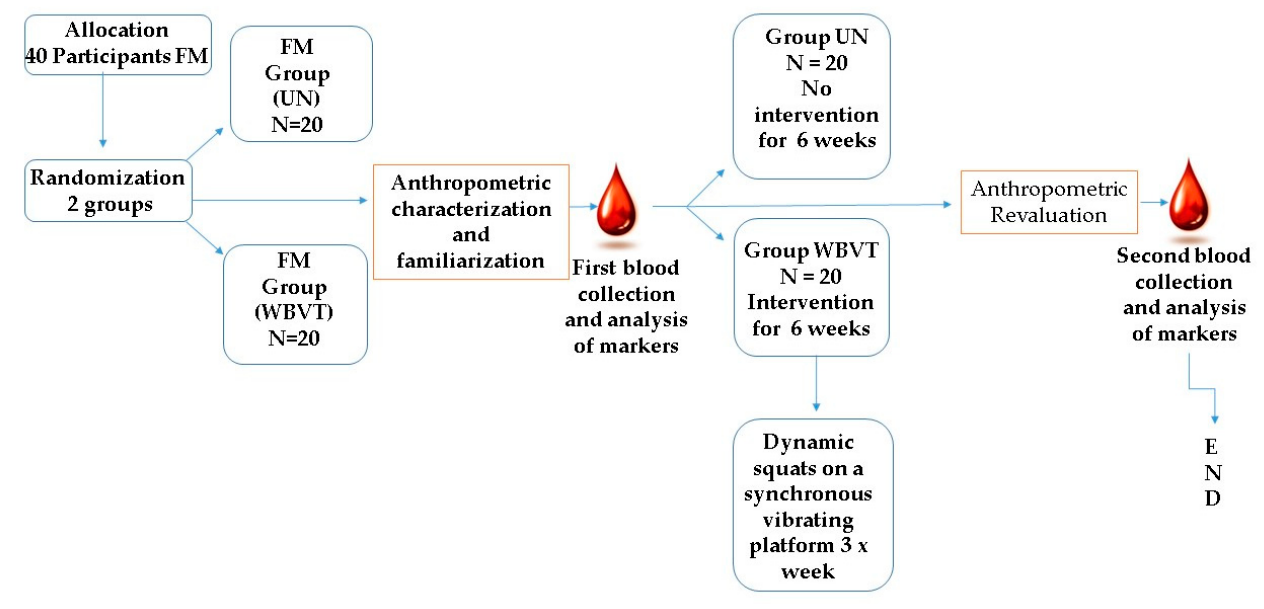
Figure 3. Diagram illustrating the study’s design. Design of the study; fibromyalgia (FM), untrained (UN), whole-body vibration training (WBVT).